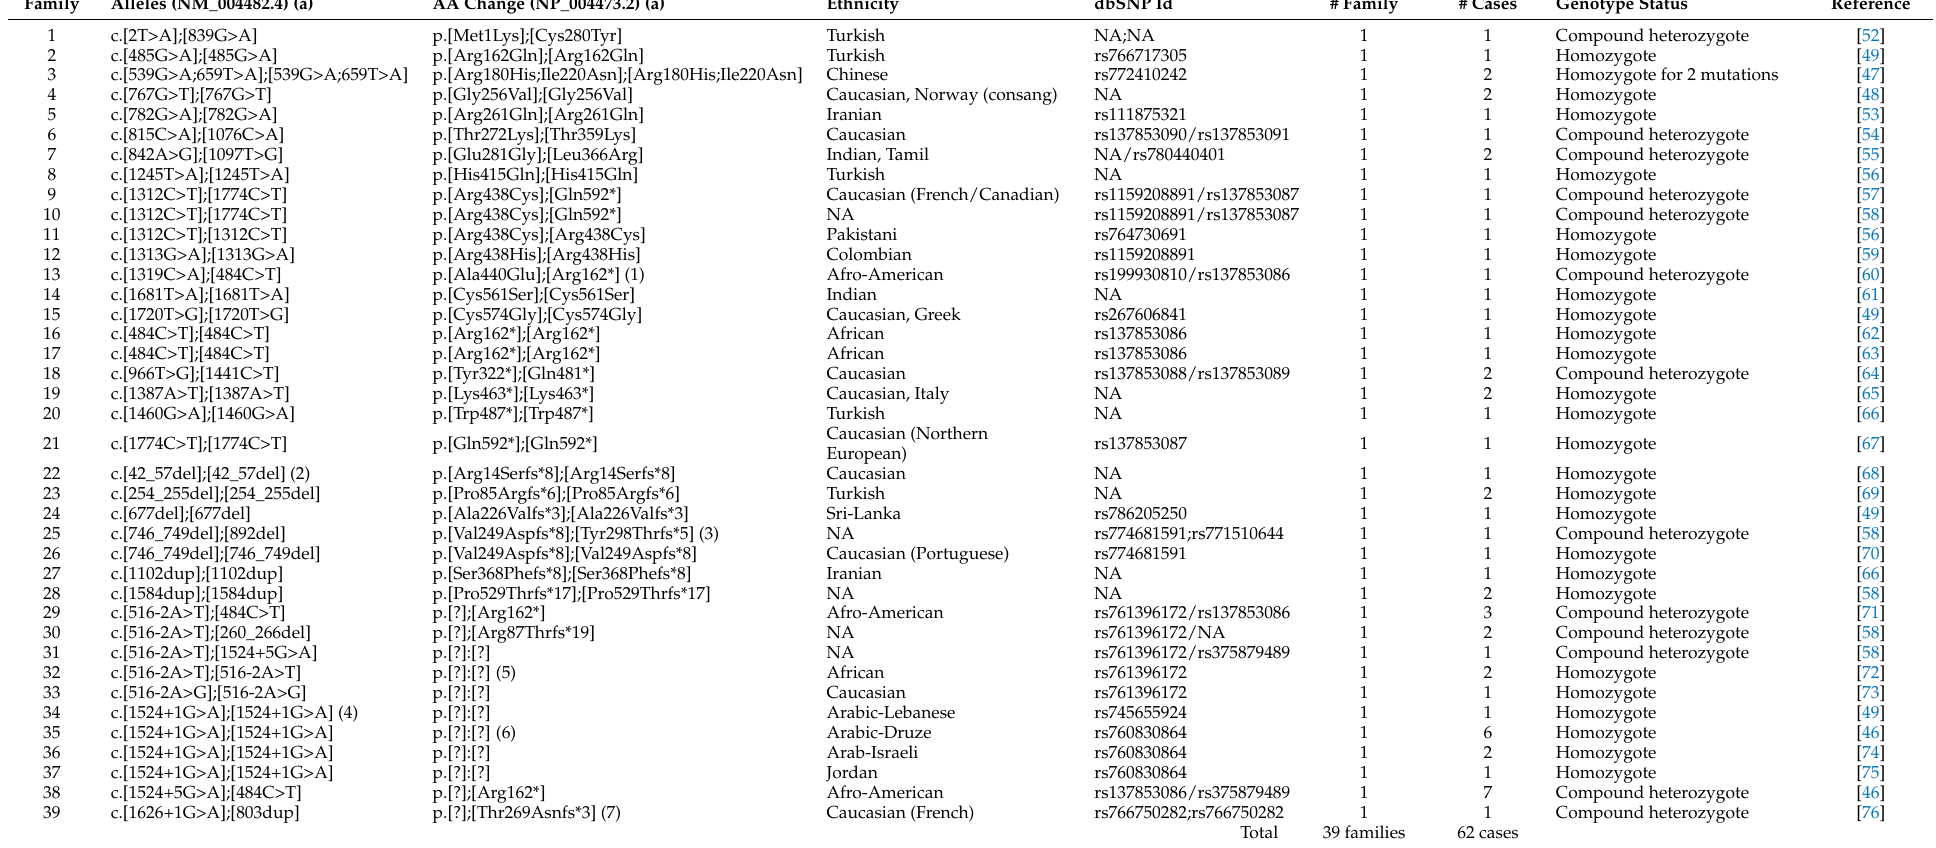
Table 2. Summary of published GALNT3 -related HFTC